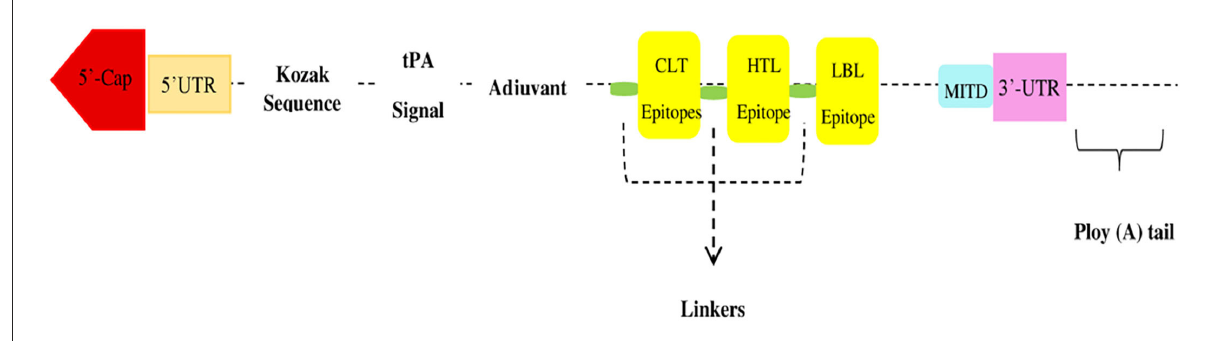
FIGURE2 Flow diagram of vaccine construct from N-terminal to